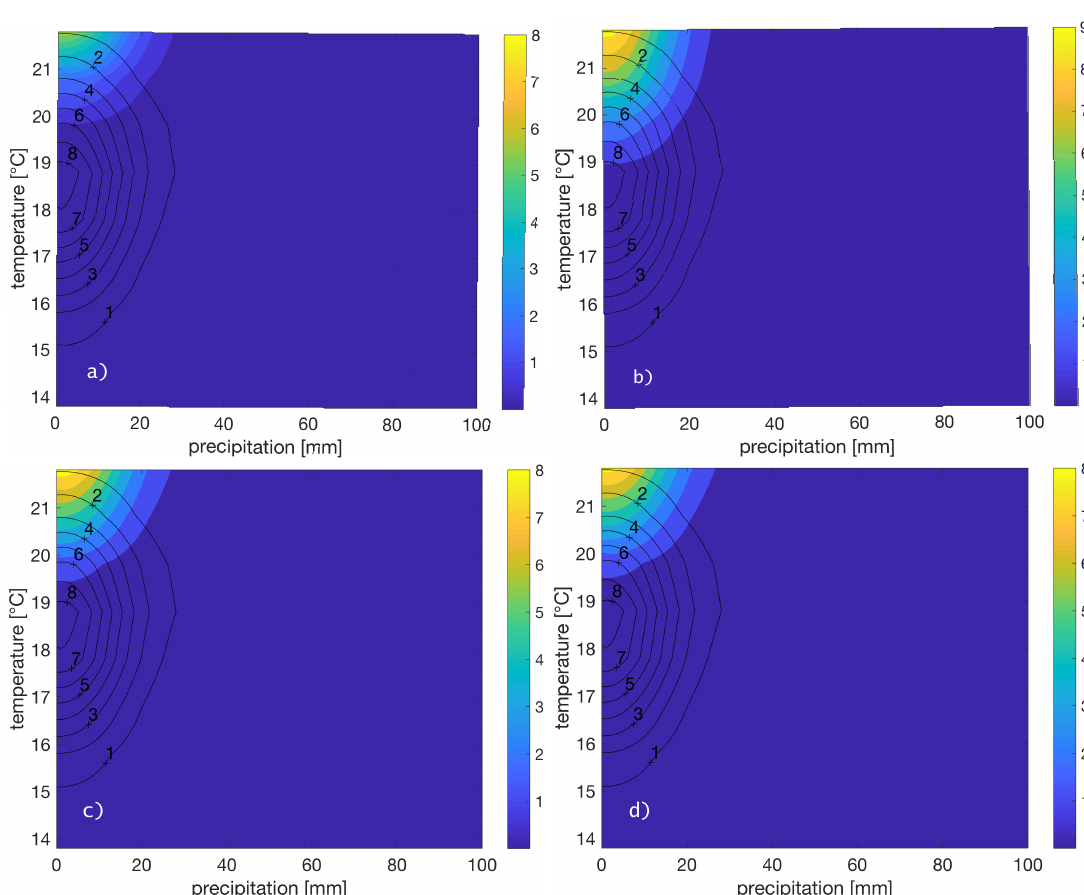
Figure 3. Same as Figure 2, but at the MERU station for the ( a ) WRF-BLA, ( b ) WRF-GWA, ( c ) WRF-KLA, and ( d ) WRF-KWA simulations. WRF physics parametrization simulations are given in color, observations as black contour lines. Estimation is based on a nonparametric kernel density approach. Note that density values are multiplied by 10 3 due to relatively flat densities. Density values were derived at the points of a predefined grid, which is given by the min/max values as well as a 1.0 increment for the P and T observations,